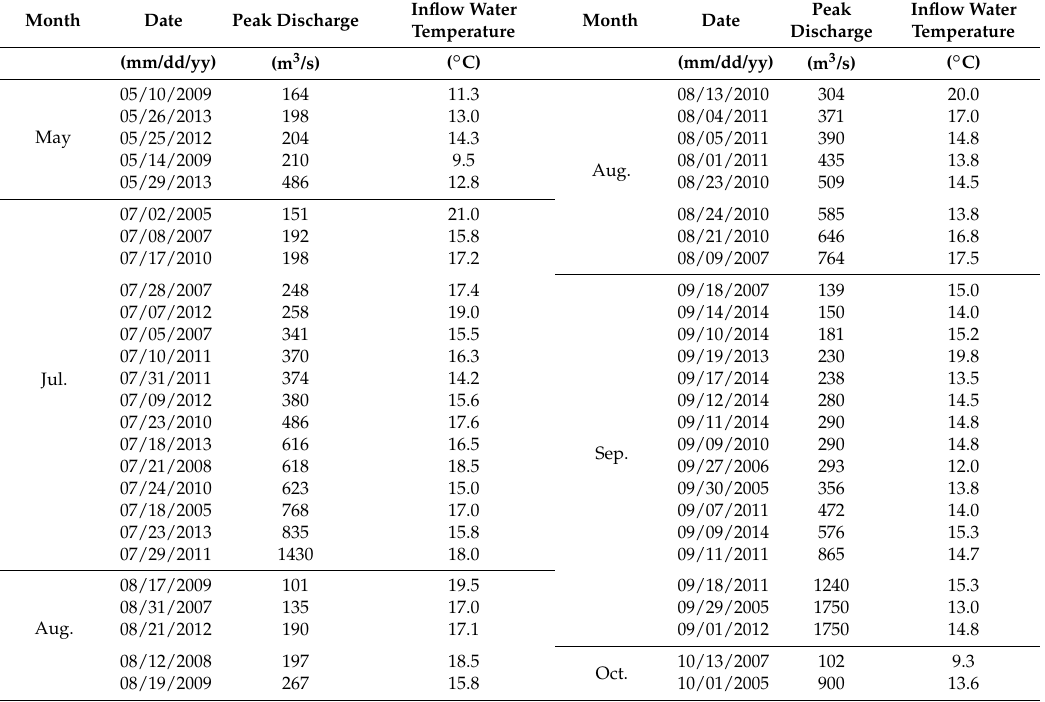
Table 2. Inflow water temperature for different peak discharges and months from 2005 to